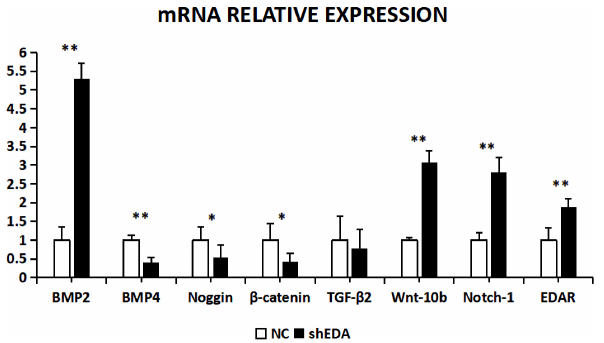
Figure 10. The mRNA relative expression of BMP2, BMP4, nog- gin, β -catenin, TGF- β 2, Wnt-10b, NOTCH1, and EDA after EDAR interference. Note: ∗ significant difference. ∗∗ Extremely significant